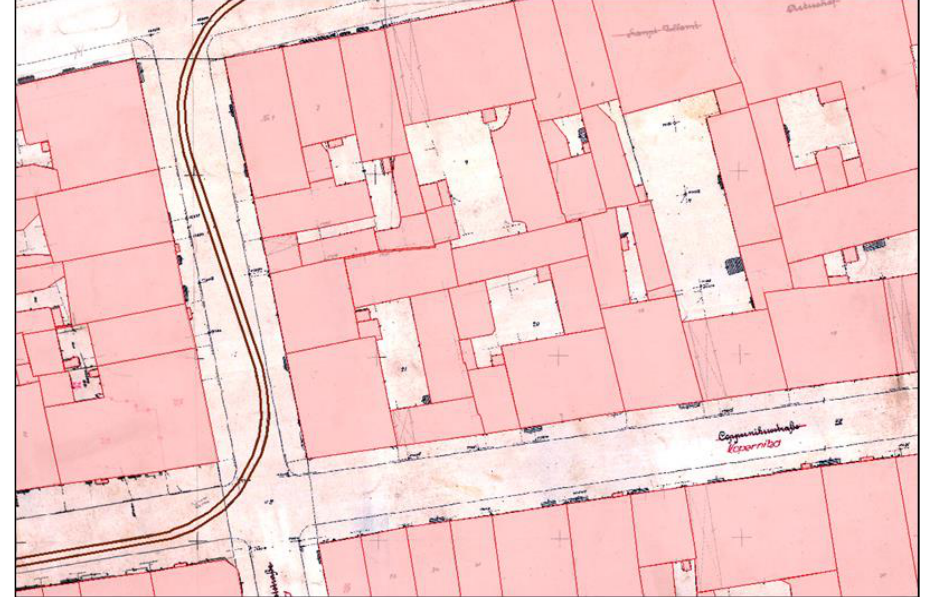
Figure 8. A fragment of the cadastral map of Toruń showing the vectorised buildings (red), the tram line (brown), and Kopernika Street with marked pavements. Source: own work based on Gemarkungskarte der Stadt Thorn, Blätter 38, 39, State Archives in Toruń.